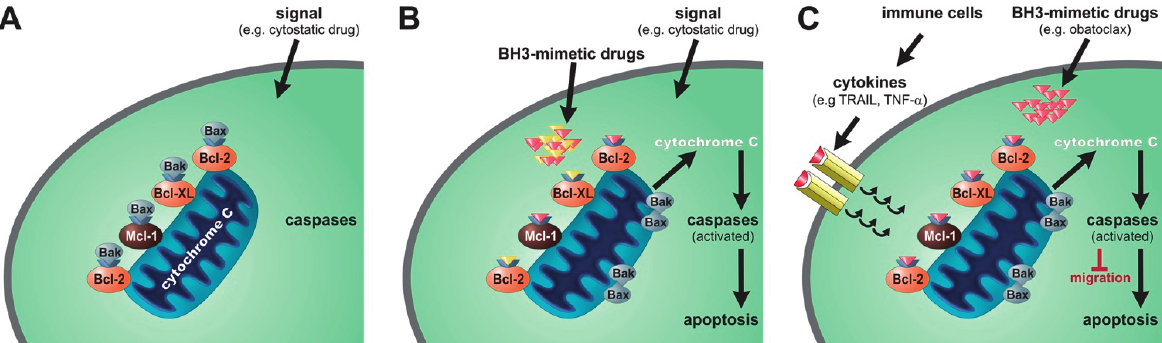
Figure 1. Effects of BH3-mimetic drugs. Overexpression of proteins of the Bcl-family in tumor cells cause capture of Bak and Bax in BH3-binding sites, which prevents initiation of the apoptosis cascade via intrinsic or extrinsic stimuli ( A ); BH3-mimetic drugs lead to the release of Bak and Bax, which oligomerize and insert as a complex in the outer mitochondrial membrane. This membrane permeabilisation is followed by cytochrome c release and other pro-apoptotic factors into the cytoplasm, initiating apoptosis and leading to cell death ( B ); BH3-mimetic drugs can enhance dead signals from immune cells (TRAIL, TNF- α ) and can influence migration of tumor cells ( C